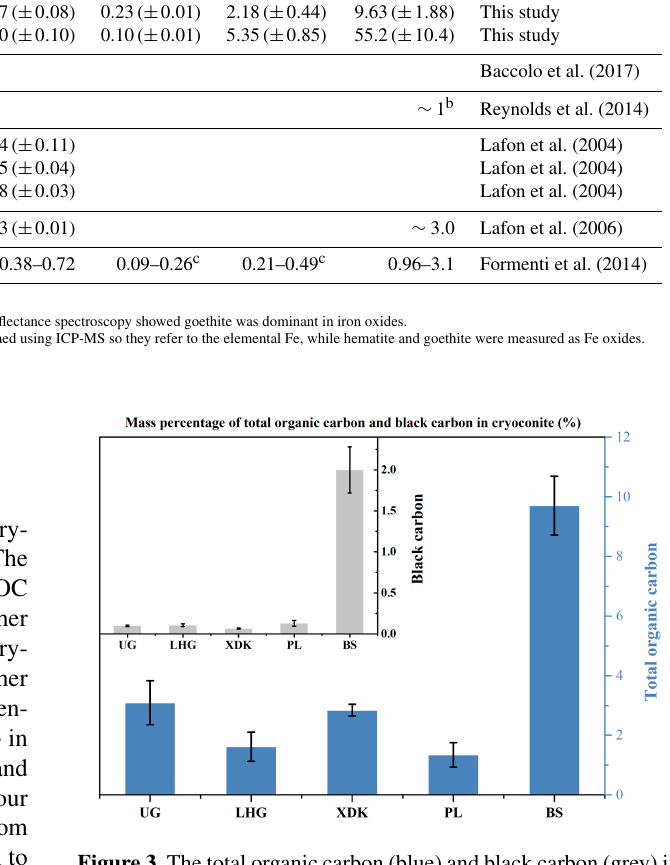
Figure 3. The total organic carbon (blue) and black carbon (grey) in the total mass of cryoconites on the mountain glaciers of the Tibetan Plateau and